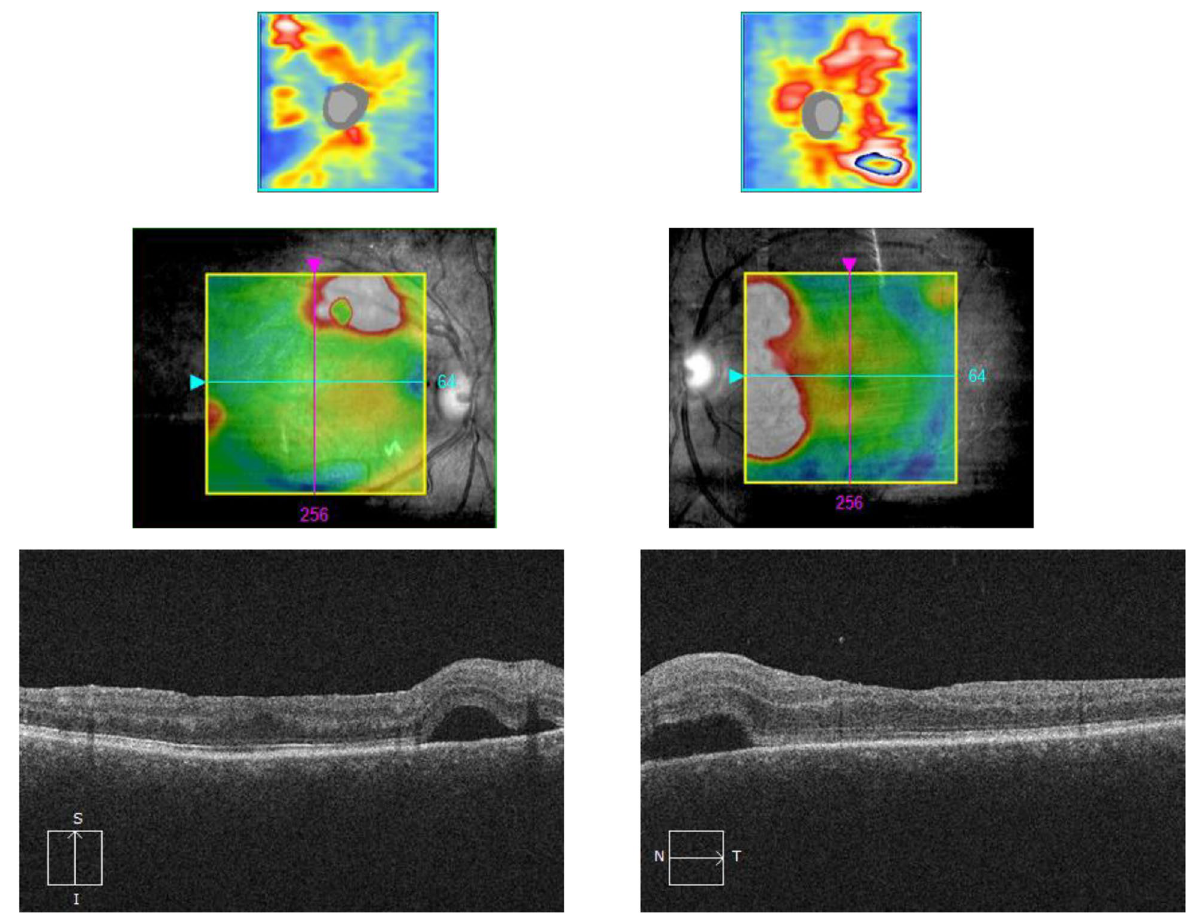
Fig. 2 OCT (ocular coherence topography) of both eyes showing bilateral peripapillary multifocal subretinal fluid more in left